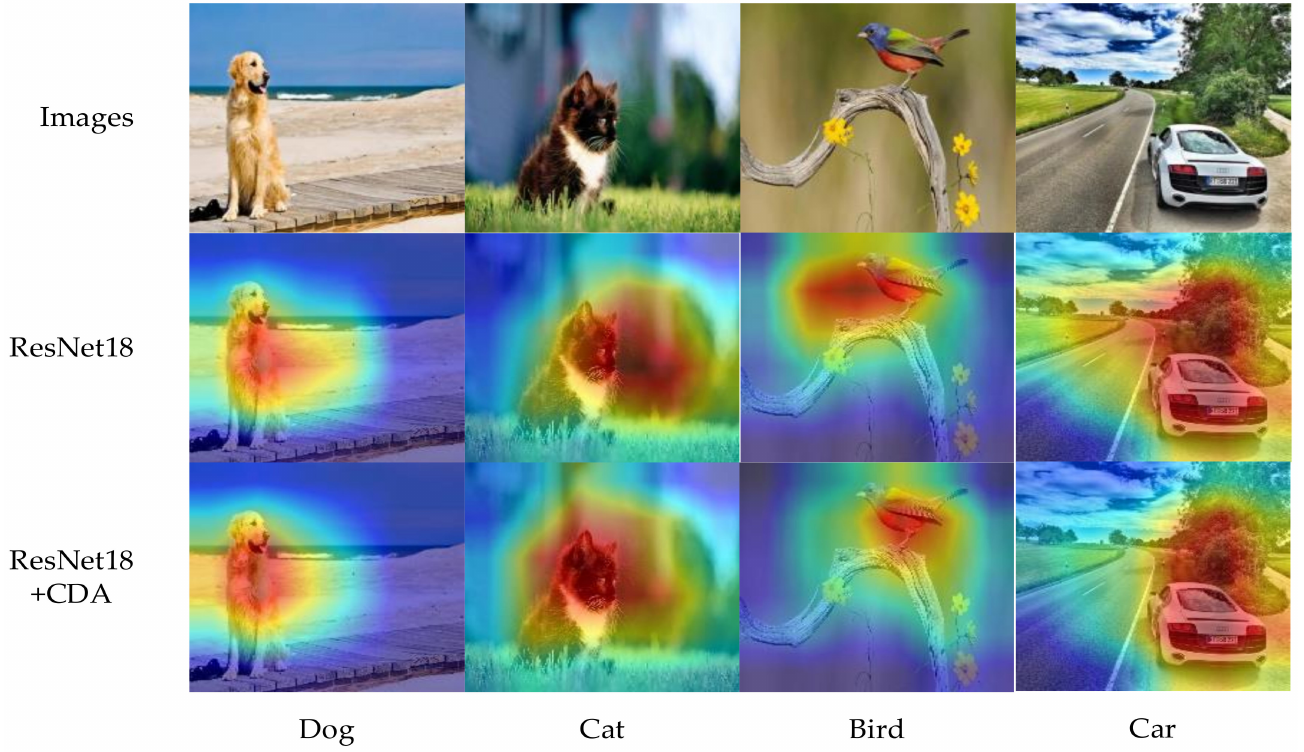
Figure 2. Visualization of feature